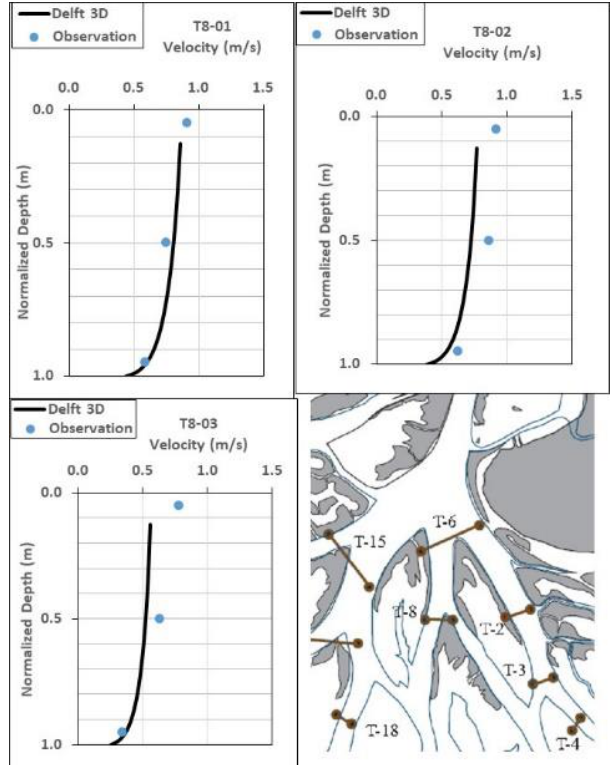
Figure 3. Calibration results showing comparison of modeled and observed velocities at Greg Pass.